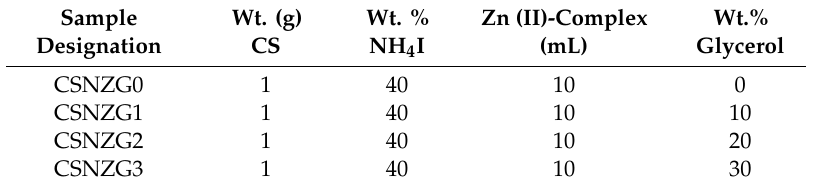
Table 1. The composition and designation of glycerolized CS:NH 4 I: Zn(II)-complex systems.